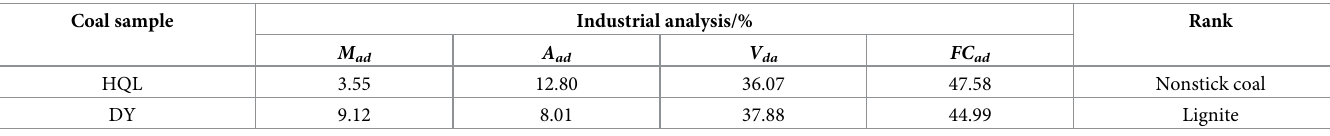
Table 1. Proximate analysis and metamorphic degree of the coal samples collected. Coal